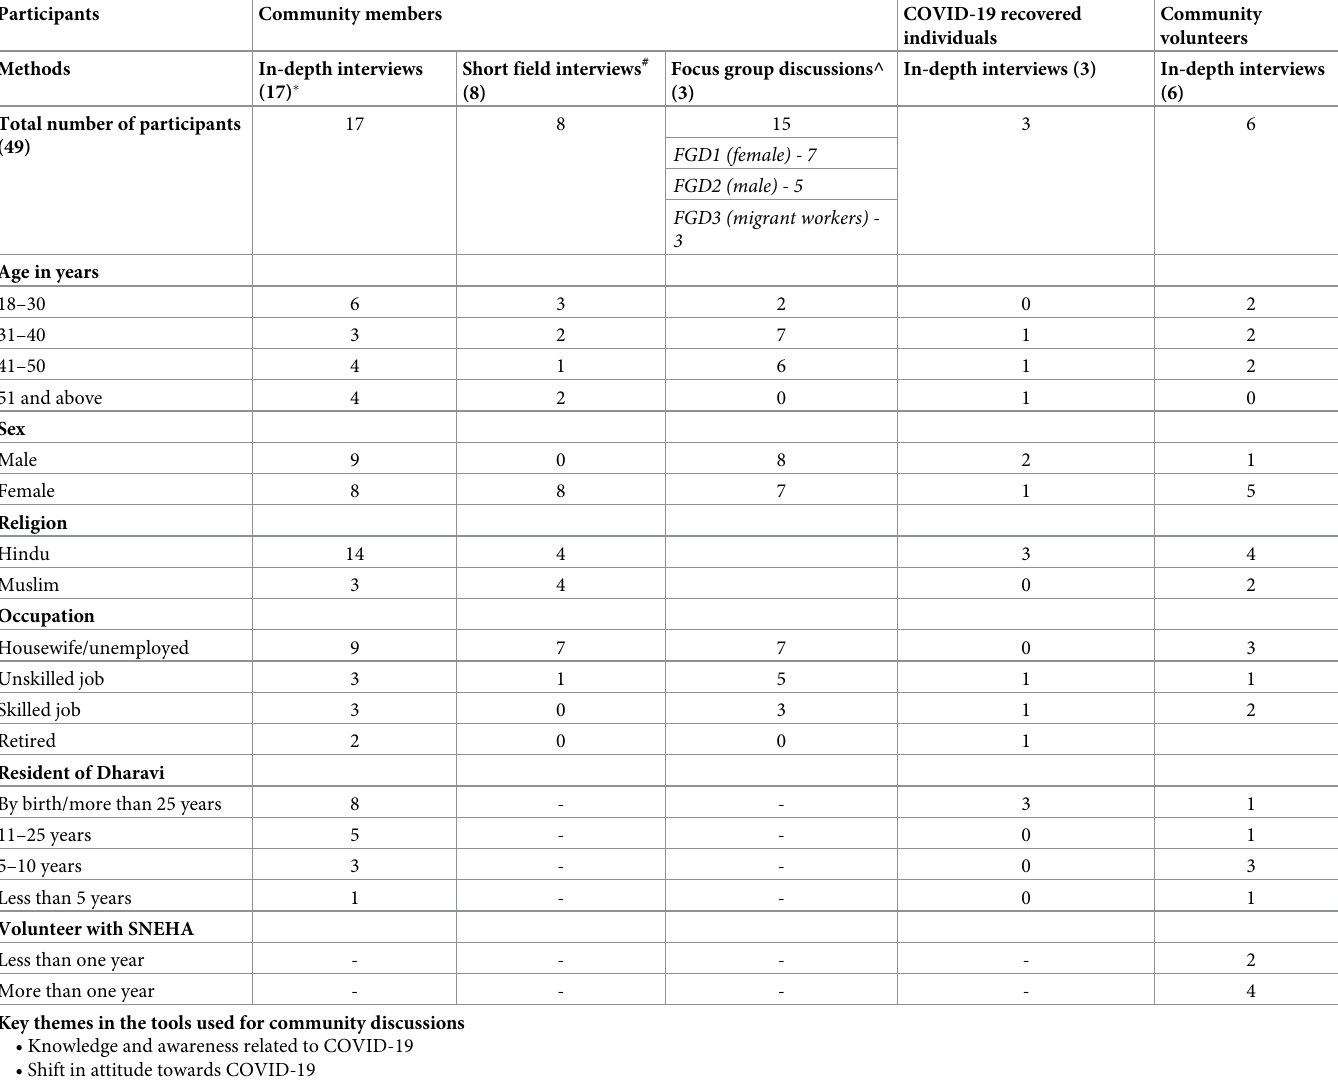
Table 1. Details of the qualitative data